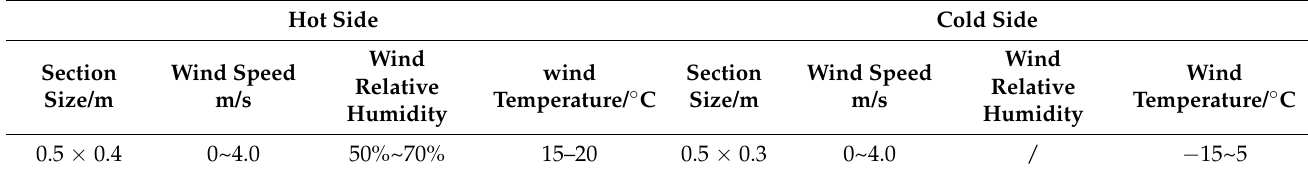
Table 1. The basic parameters of the gravity heat pipe heat exchange unit.